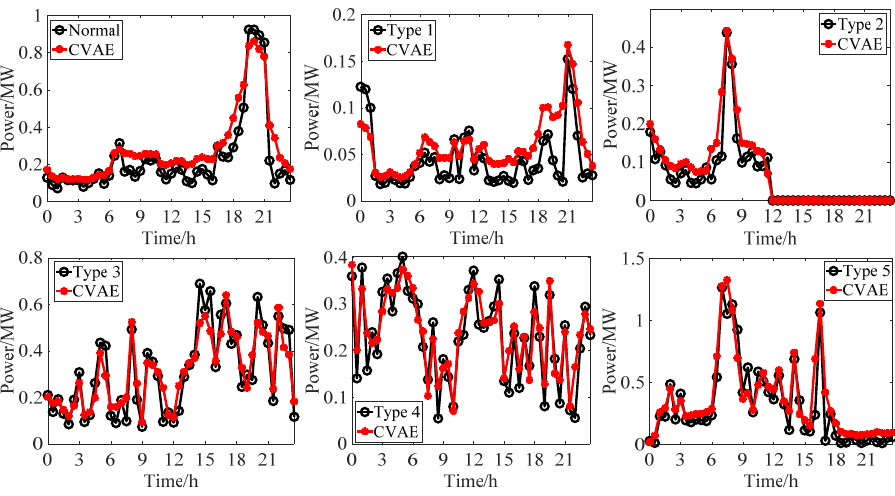
Figure 6. Comparison of shapes between real samples and generated samples.